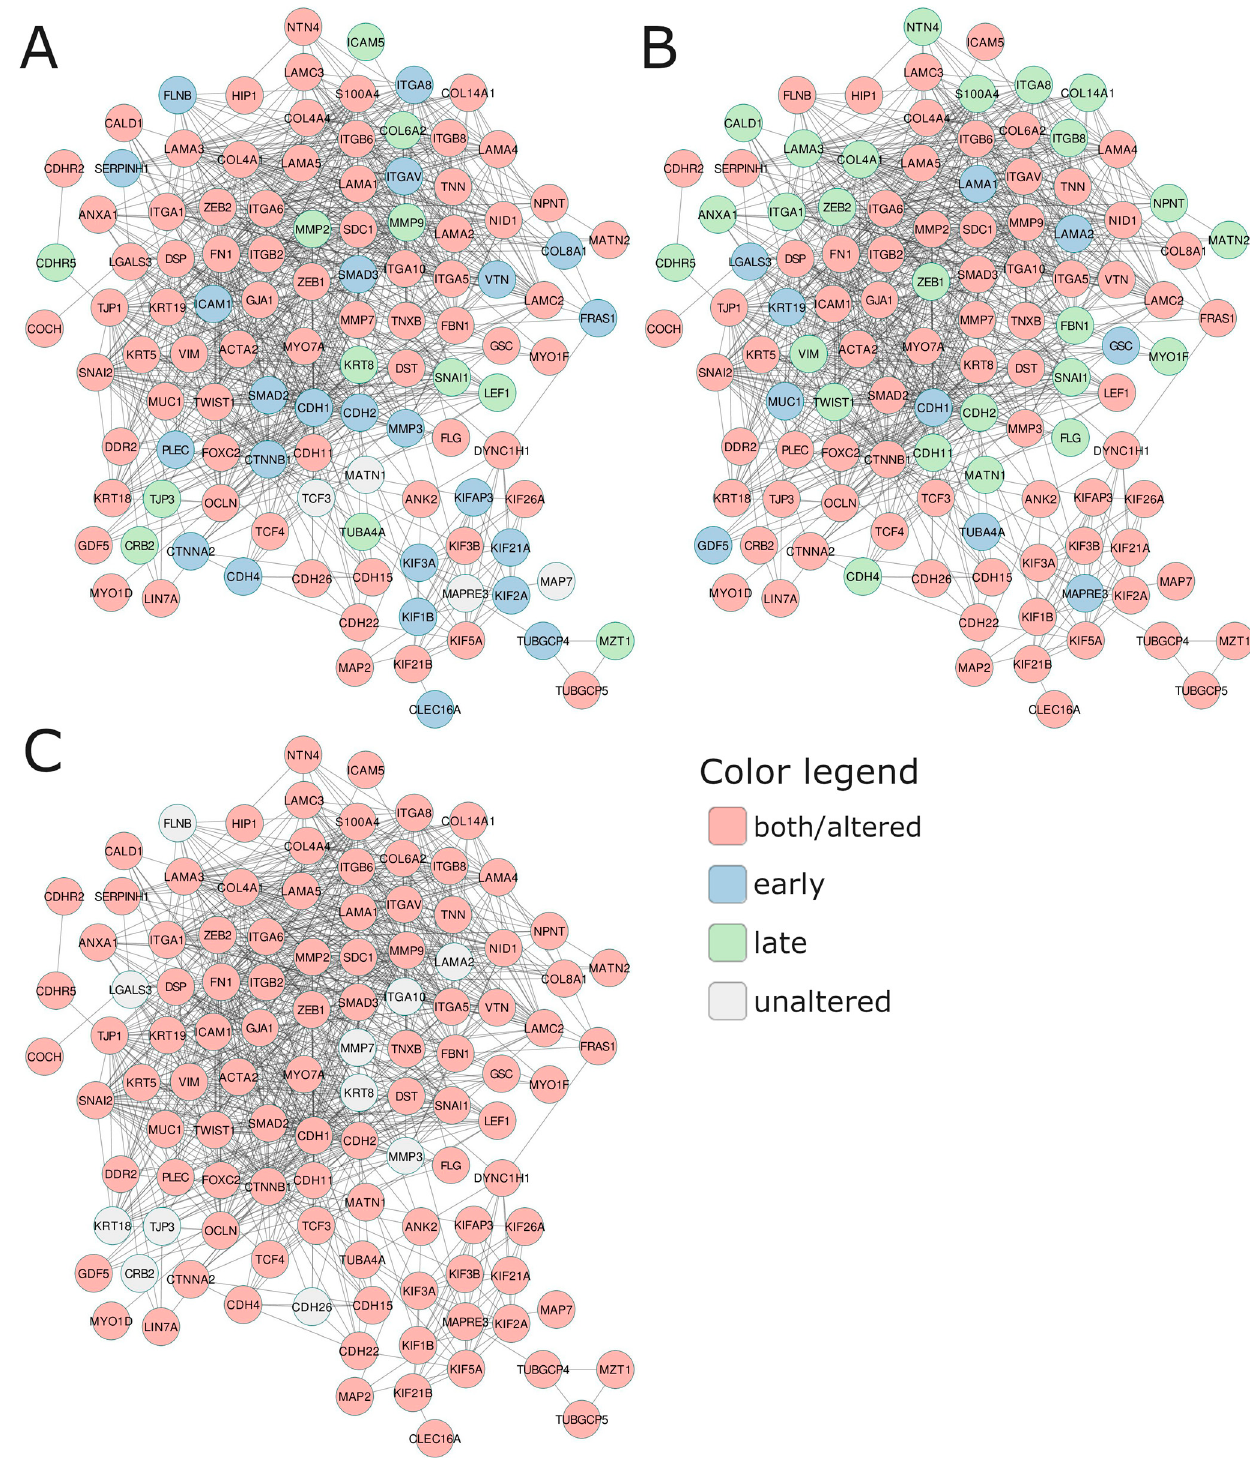
Figure 4. The functional network comprising the most essential invasion-related molecules shows expression profiles shared by ( A ) early-onset PC, ( B ) 60–70-year-old PC patients, and ( C ) elderly PC patients, reflecting the DFS prognosis according to the specific Notch signature. The adjacent Table 6 presents fold change (FC) of gene expression across different subgroups of patients.